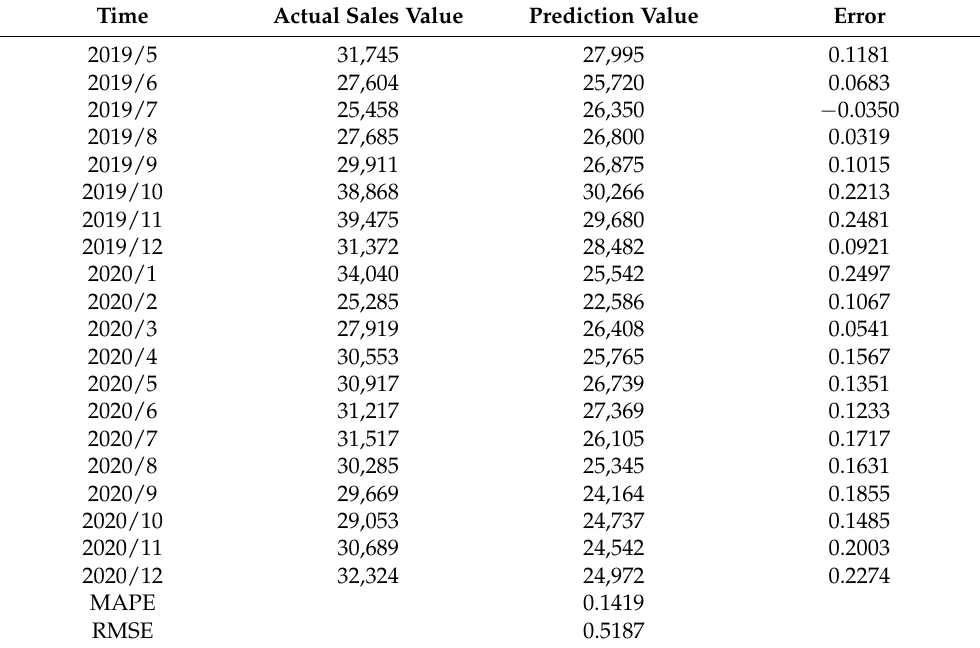
Table 4. The model fitted the prediction results of Kaluola.